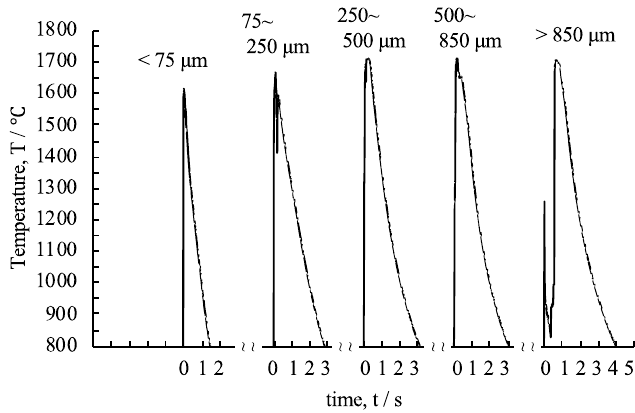
Figure 9. Temperature curves of the Al / Ni multilayer powders during the exothermic reaction measured by the pyrometer as a function of the classified particle sizes.